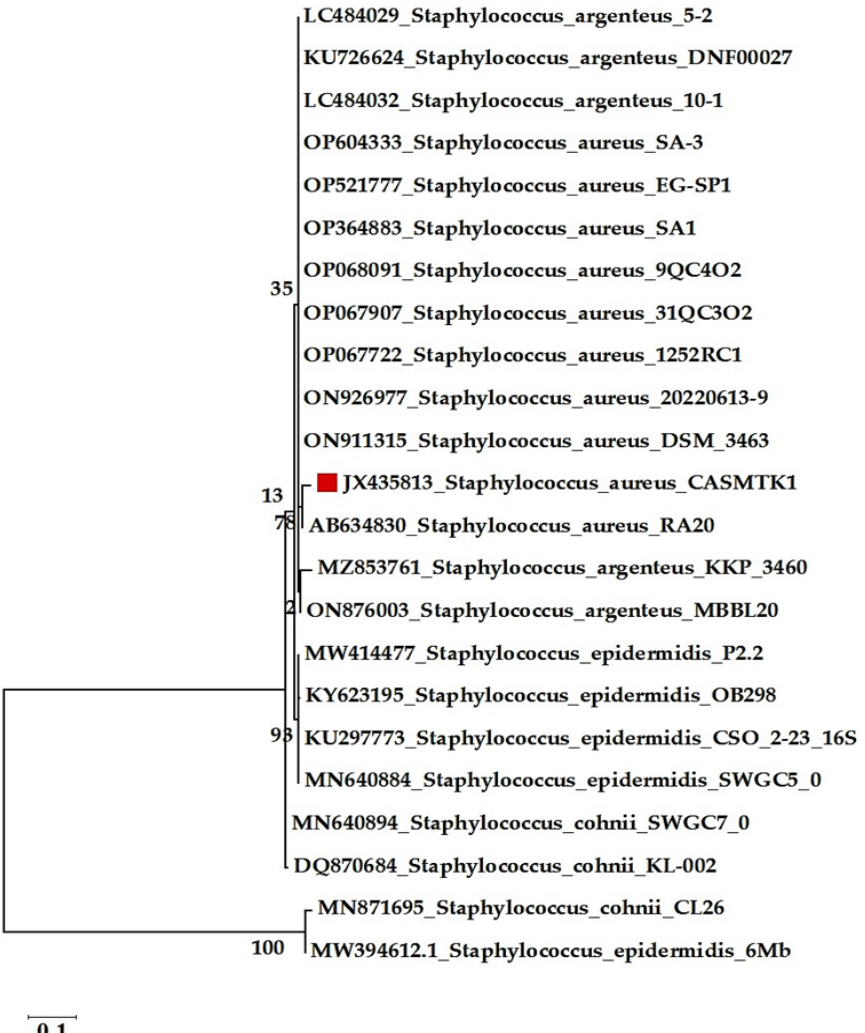
Figure 2. Maximum Likelihood phylogenetic tree analysis of CSMTK1 with 16S rRNA gene sequence and values are expressed as percentage of 1000 replications as shown at the branch points (red square = this study organism).